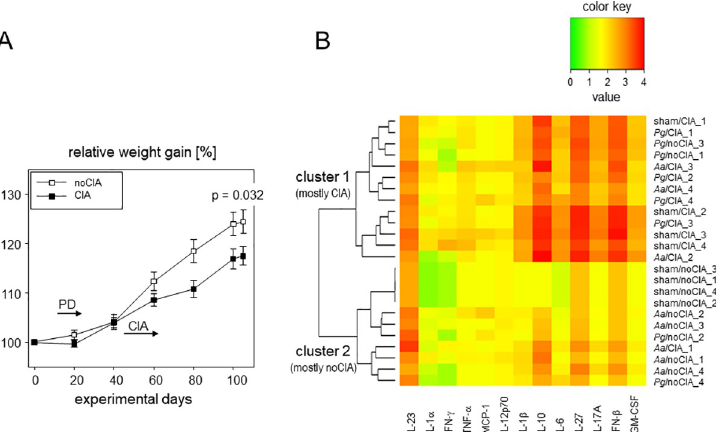
cytokines (listed below the heat map) at endpoint. The color key is shown above, individual animals are listed on the right and the dendrogram on the left visualizes the connectedness between animals. N = 4 per group were analyzed.